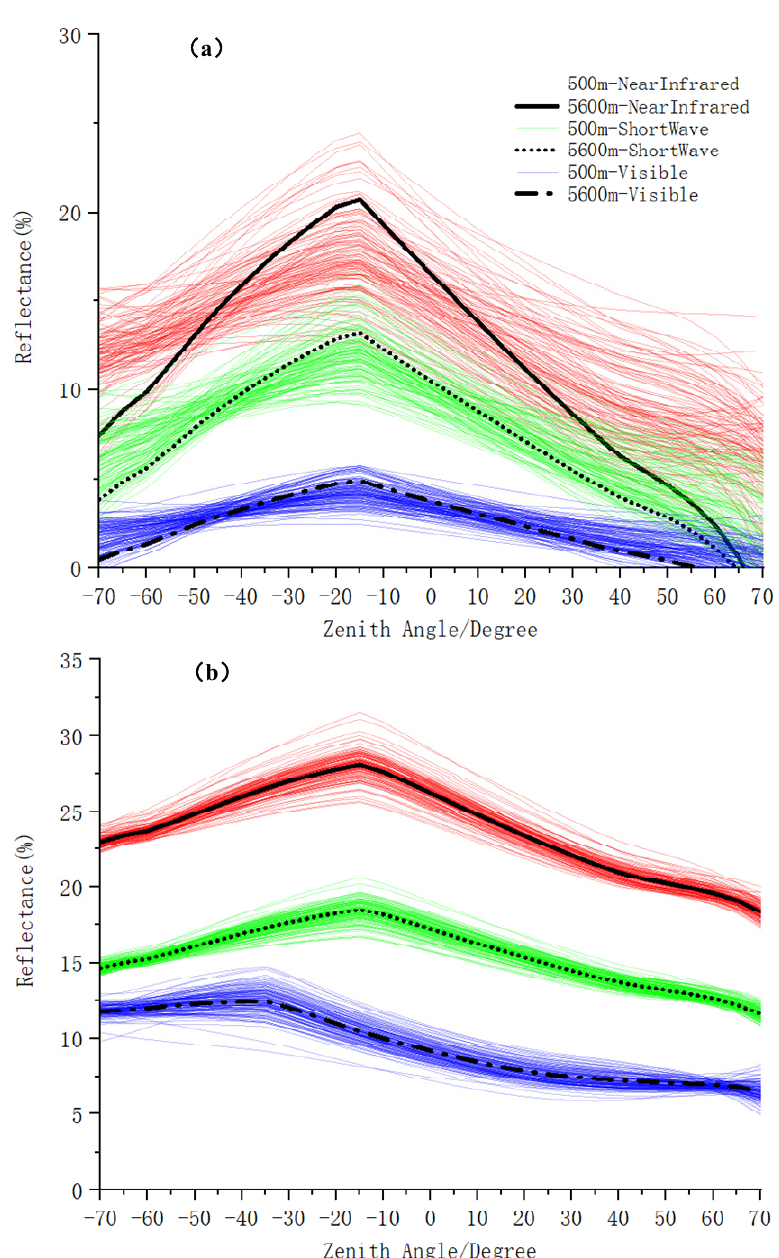
Figure 10. Comparison of smoothed BRDF principal plane at 5600 m with the retrievals at 500 m within three broadbands on the extreme DOYs for ENF ( a ) and Grassland ( b ). Table 4. Differences in BRDF principal planes due to spatial smoothing for ENF and Grassland in extreme DOYs.